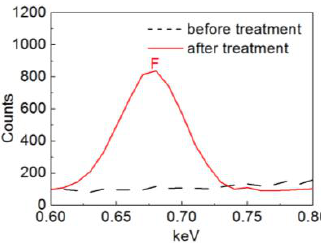
Figure 4. Energy dispersive X-ray spectroscopy (EDS) results for silica nanoparticles with fluoroalkyl silane, 1 H ,1 H ,2 H ,2 H -perfluorooctyltriethoxysilane (POTS) treatment and without treatment.